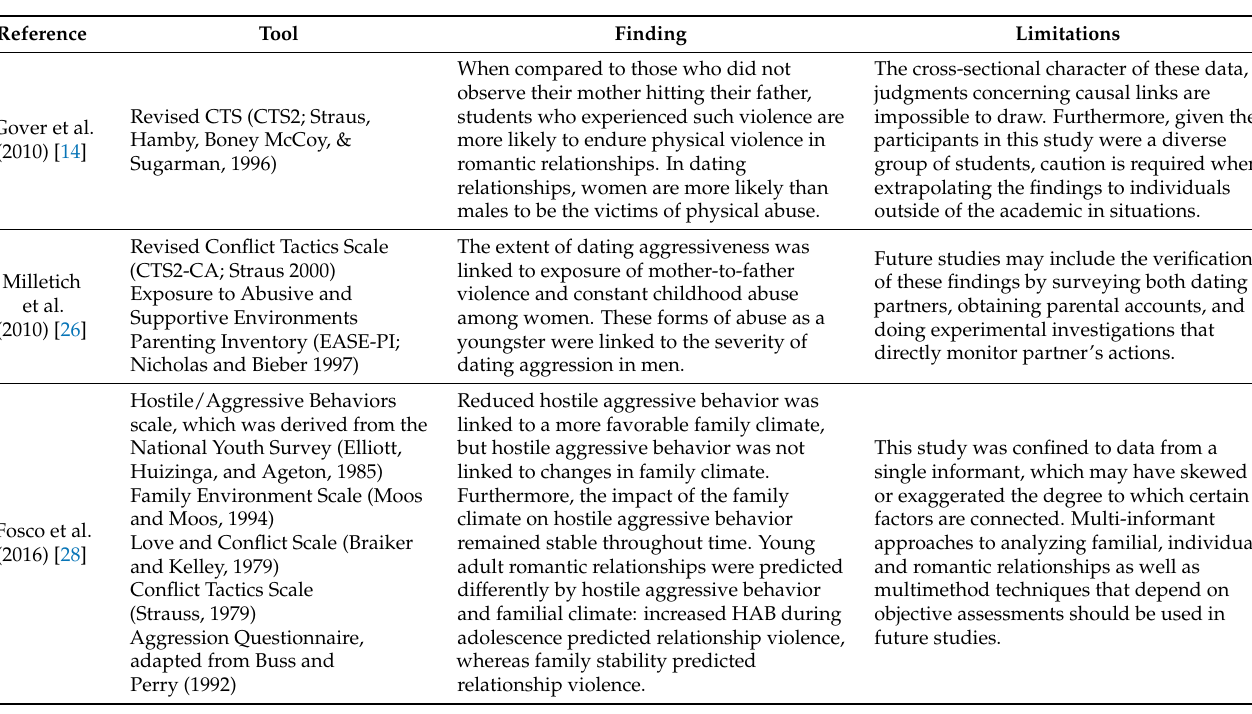
Table 4. Findings of